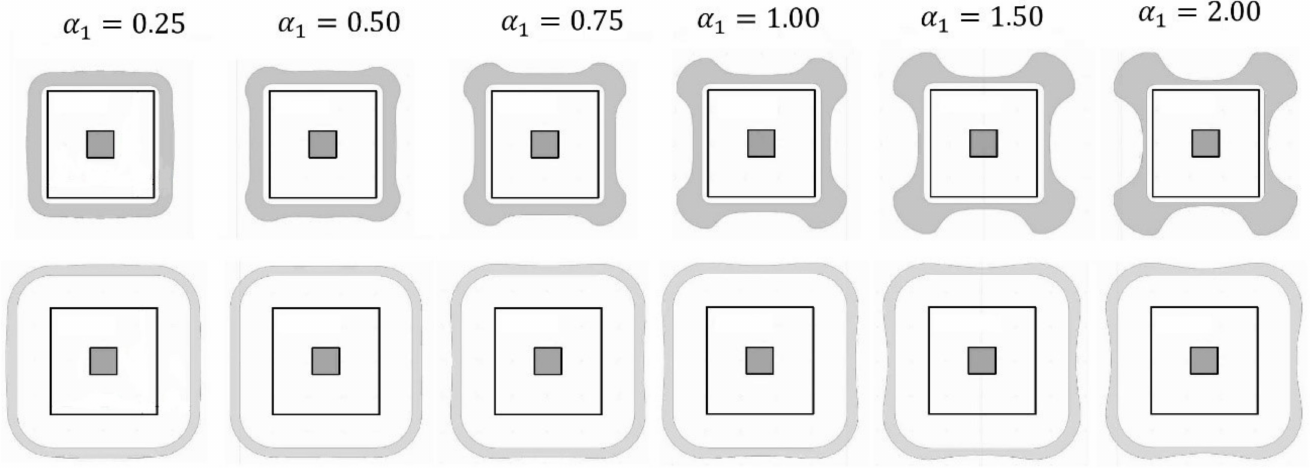
Figure A2. Graphs of the shear forces in the control perimeter depending on the shear cap height—120 cm shear cap width (c/d = 6).